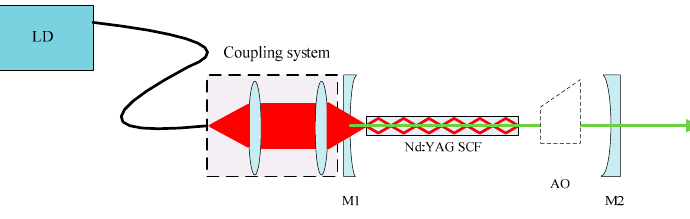
Figure 1. Schematic diagram of the 1443.5 nm Nd:YAG SCF laser.